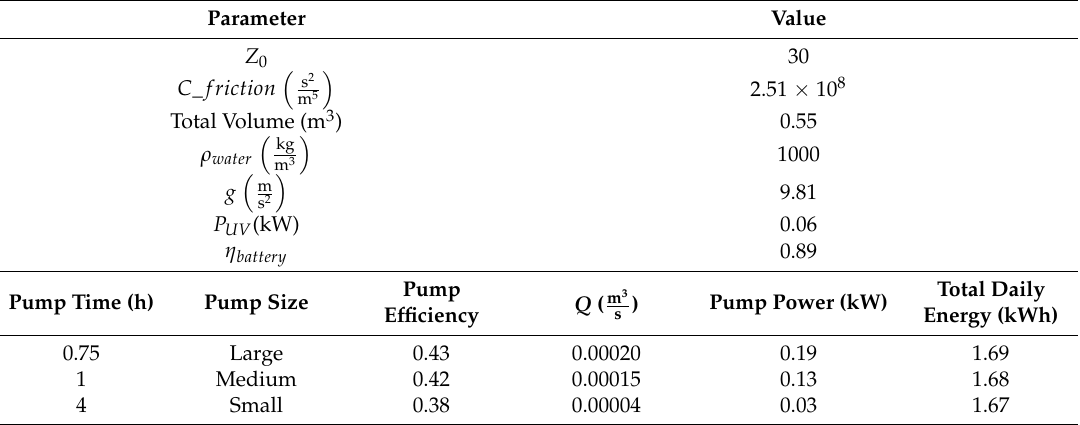
Table A5. Pressurized storage, UV lamp always on